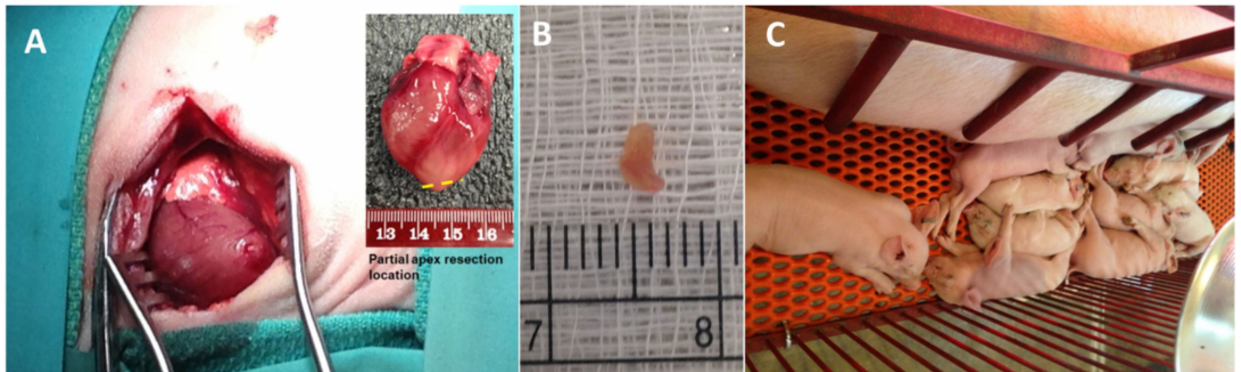
Figure 1. ( A ) Partial apex resection surgery performed on neonatal piglets. Inserted image schemati- cally shows the partial apex resection location. ( B ) Heart muscle tissue resected from the apex of a piglet heart. ( C ) Piglets resting with mother sow after surgery. Table 2. Surgery information for each piglet. The table summarizes sex, body weight, resected tissue mass, and age of the piglets.